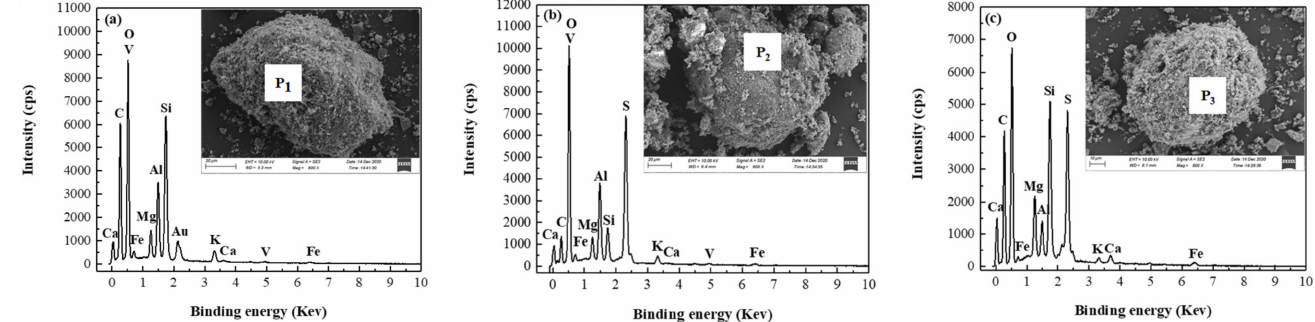
Figure 7. SEM-EDS analysis of vanadium ore ( a ), roasted ore ( b ), and leaching residue ( c